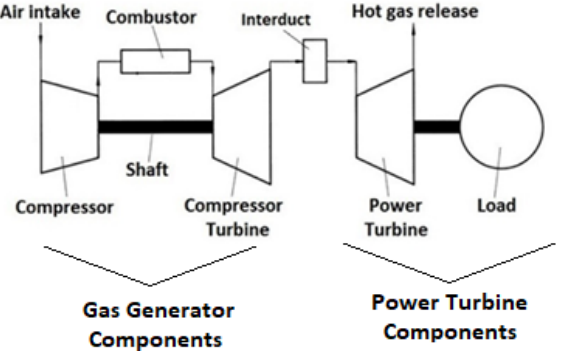
Figure 5. Representation of 0-D engine model developed in the Simulink environment.